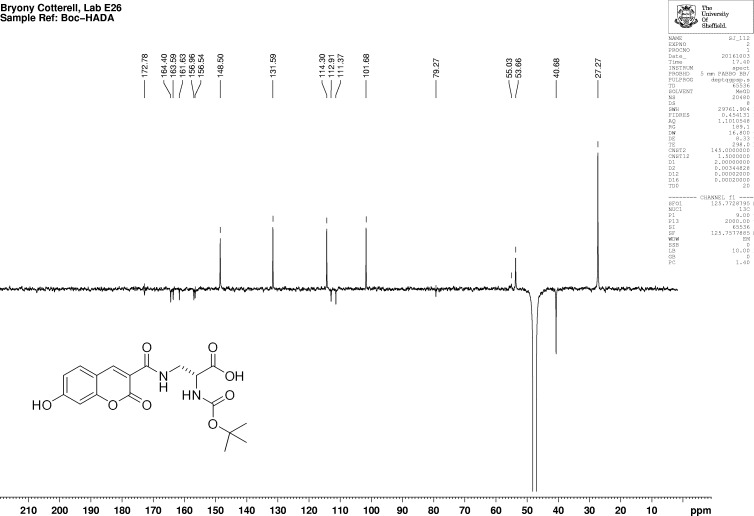
1D 13C NMR Spectrum of N-[(1,1-Dimethylethoxy)carbonyl]−3-{[(7-hydroxy-2-oxo-2H-1-benzopyran-3-yl) carbonyl] amino} D-alanine (N-Boc-HADA).